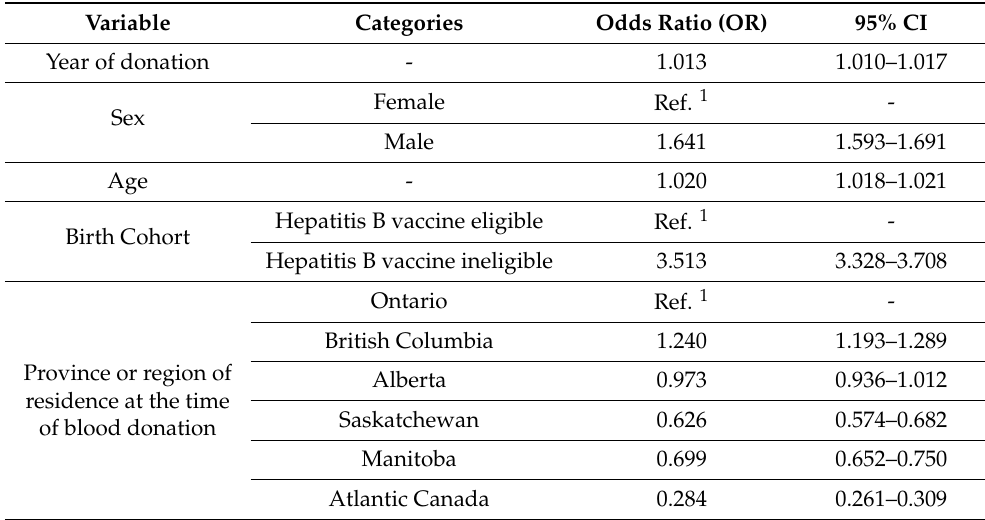
Table 7. Output from multivariable logistic regression model, with clinical scenarios 1/3 (likely resolved/occult infection) as the dependent variable.